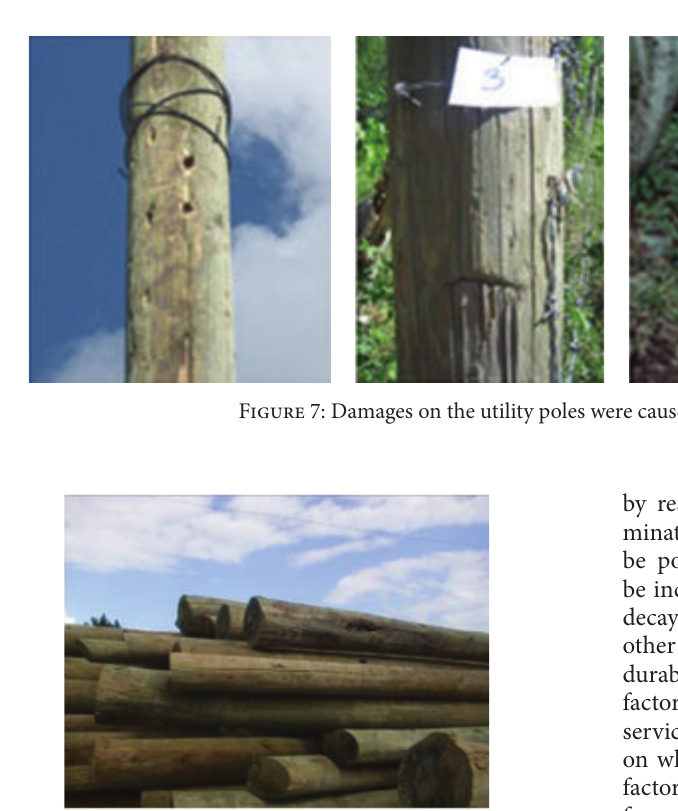
Figure 6: Deep cracks and checks on the utility poles.